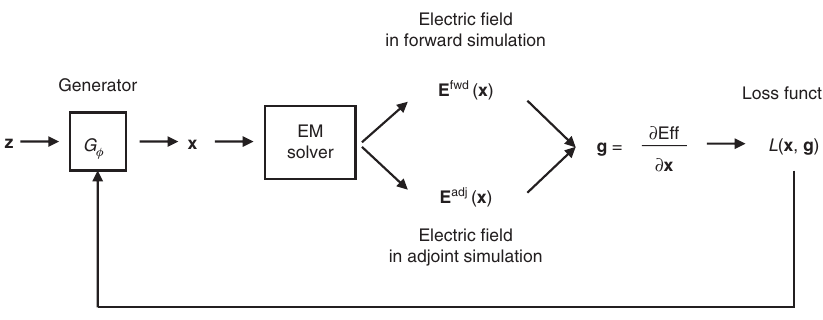
Figure 2: Schematic of generative neural network-based